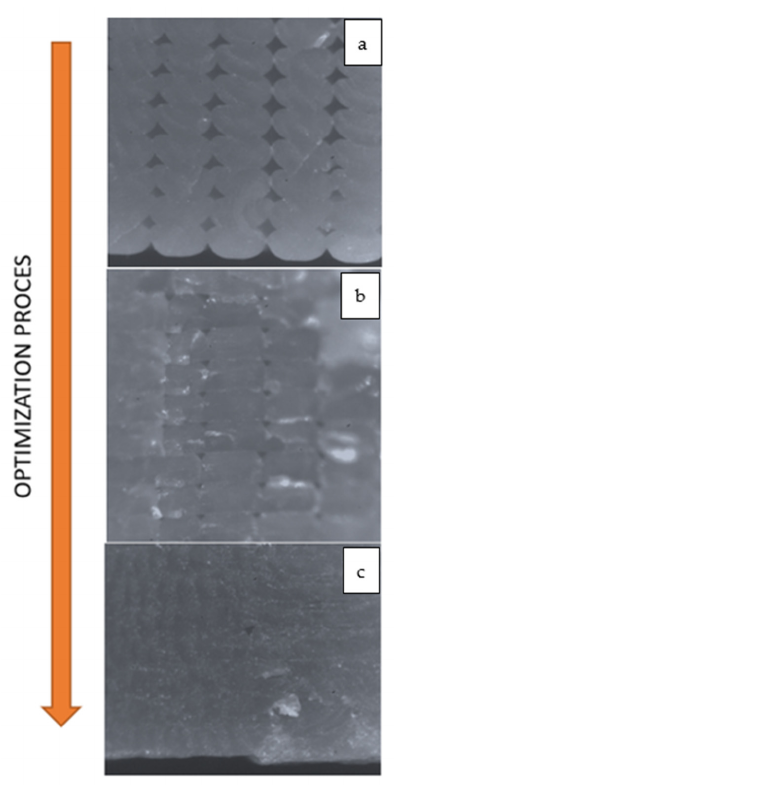
Figure 16. Printing quality on the microscope (20 × ): ( a ) not optimized; ( b ) increasing performance; and ( c ) fully optimized.